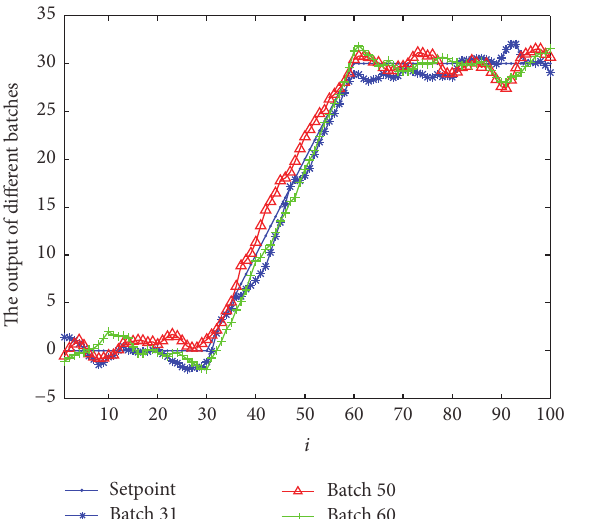
Figure 4: The controlled output with a process change 𝐺 𝑝 = (0.6 − = (0.45 − 0.3𝑧 −1 )/(1 − 0.7𝑧 −1 ) . 0.3𝑧 −1 )/(1 − 0.7𝑧 −1 ) → 𝐺 𝑝